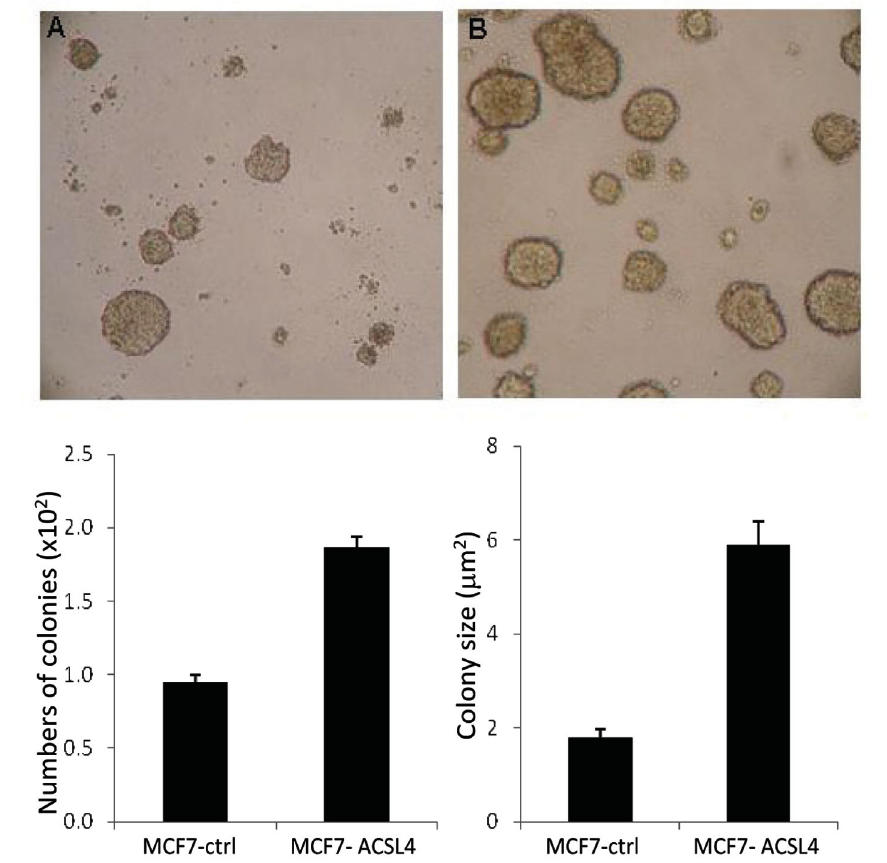
Figure 3. Effect of ACSL4 expression on anchorage-independent growth of MCF-7 cells. MCF-7 cells were stably transfected with ACSL4 cDNA utilizing a lentivirus vector, and control- and ACSL4-tranfected cells compared with respect to anchorage- independent growth as described in the text. Panel A,shows control cells, and panel B are ACSL-4-expressing cells. Panel C quantitates the number of colonies and panel D, the size of the colonies. Values shown in (C) and (D) are the means of triplicate determinations ± 1SD. The differences shown are significant: For C, p= 0.028 and for D, p=0.009. doi: